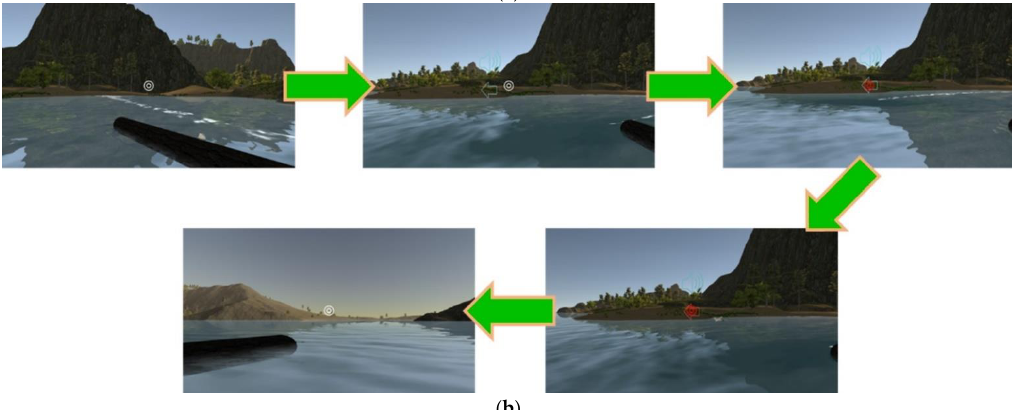
Figure 9. ( a ) Procedure for “going to next video clip.” ( b ) Procedure for “going to previous video clip.” 4.